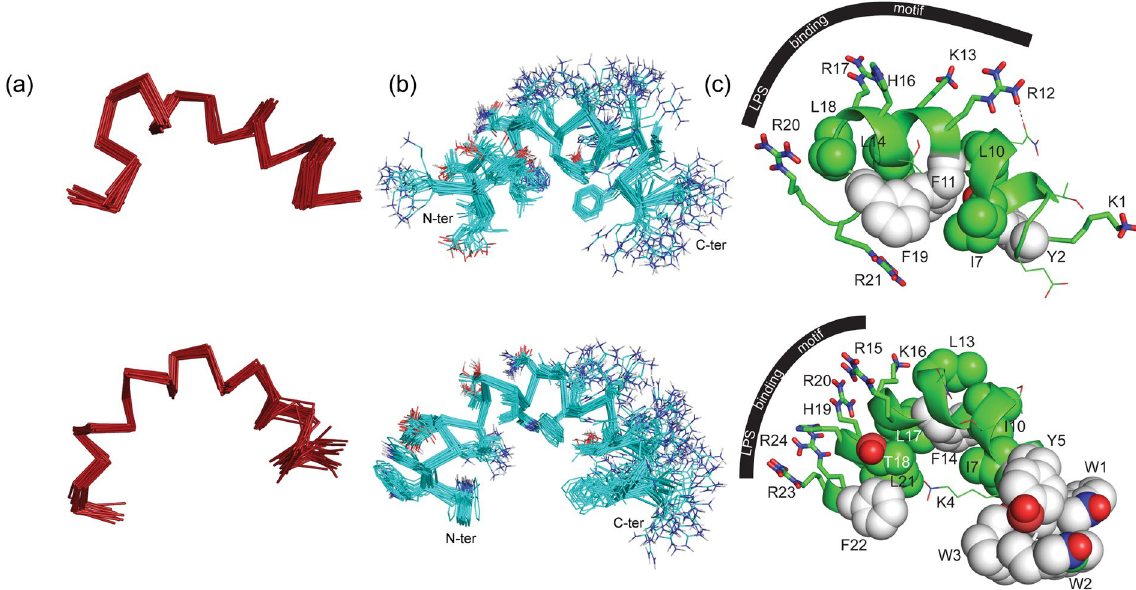
Figure 6. NMR-derived three-dimensional structures of KYE21 (pdb acquisition code: 2NCU) and WWWKYE21 (PDB acquisition code: 2NCW) in LPS micelles. ( a ) Ribbon representation of the ensemble of 20 lowest energy structures of KYE21 (upper panel) and WWWKYE21 (lower panel), showing a superimposition of the backbone (C α , N and C ′ ) atoms. ( b ) Ribbon and line representation of the 20 lowest energy ensemble structures of KYE21 (upper panel) and WWWKYE21 (lower panel), showing the superimposition of the backbone and the side chain atoms. ( c ) Cartoon representation of the orientations of the single structures of KYE21 (upper panel) and WWWKYE21 (lower panel) bound to LPS micelles, with aromatic (white color) and hydrophobic residues participating in the hydrophobic hub of the molecule indicated. The side chains of the arginine, lysine, and histidine residues participating in the polar face are shown in stick representation. All figures have been prepared using